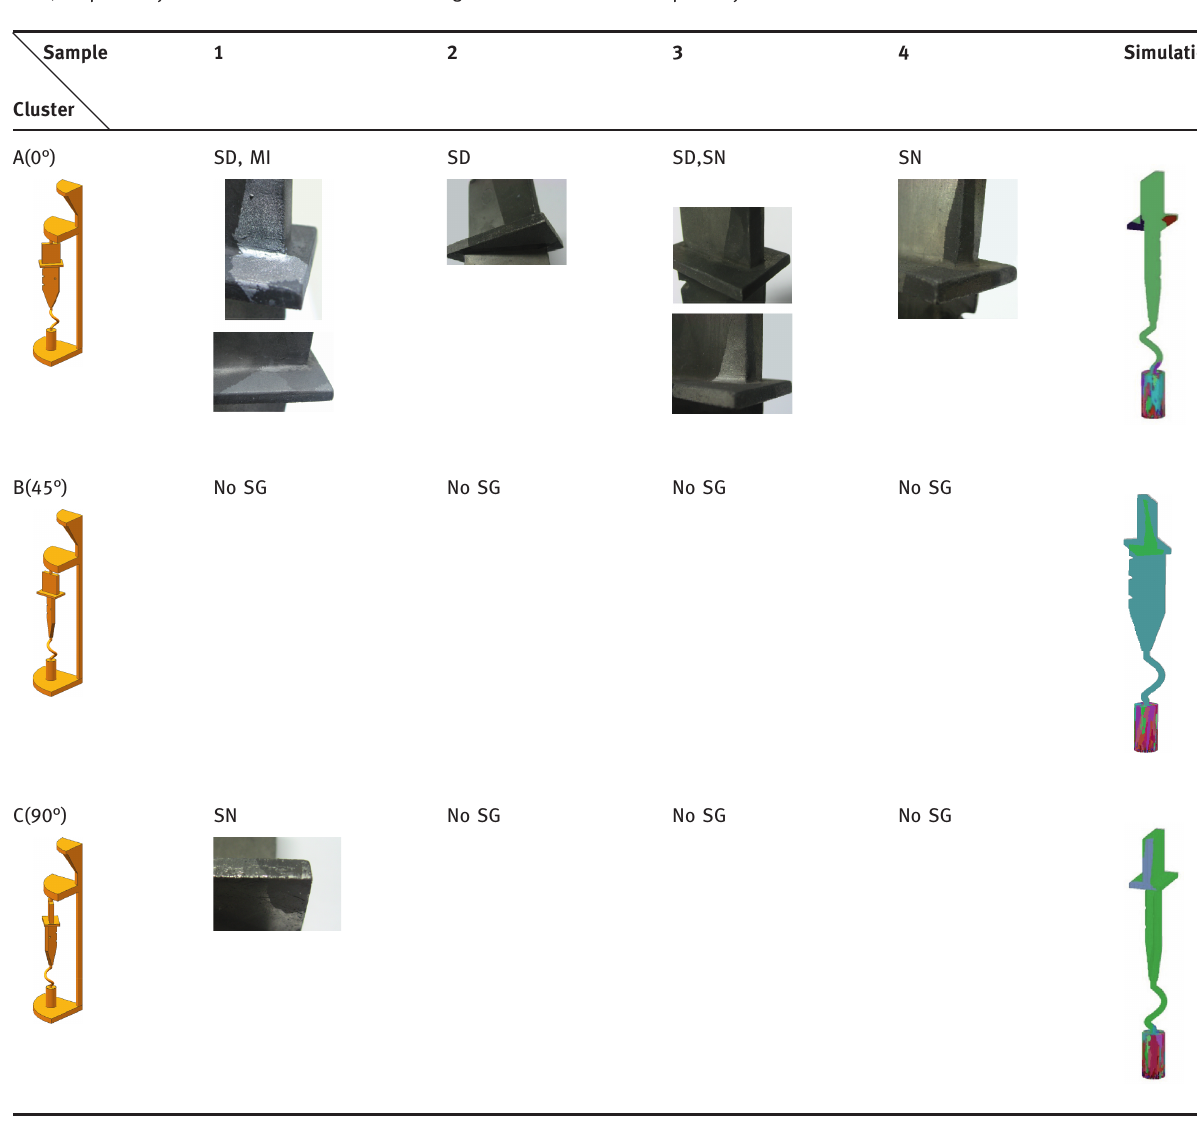
Table 2: Variation of SG formation with different CMMCs, where SD, SN and MI denote shadow side, radiation side (Figure 3(b)) and middle area, respectively. The CA simulation of solidified grain structure in DD6 superalloy is also